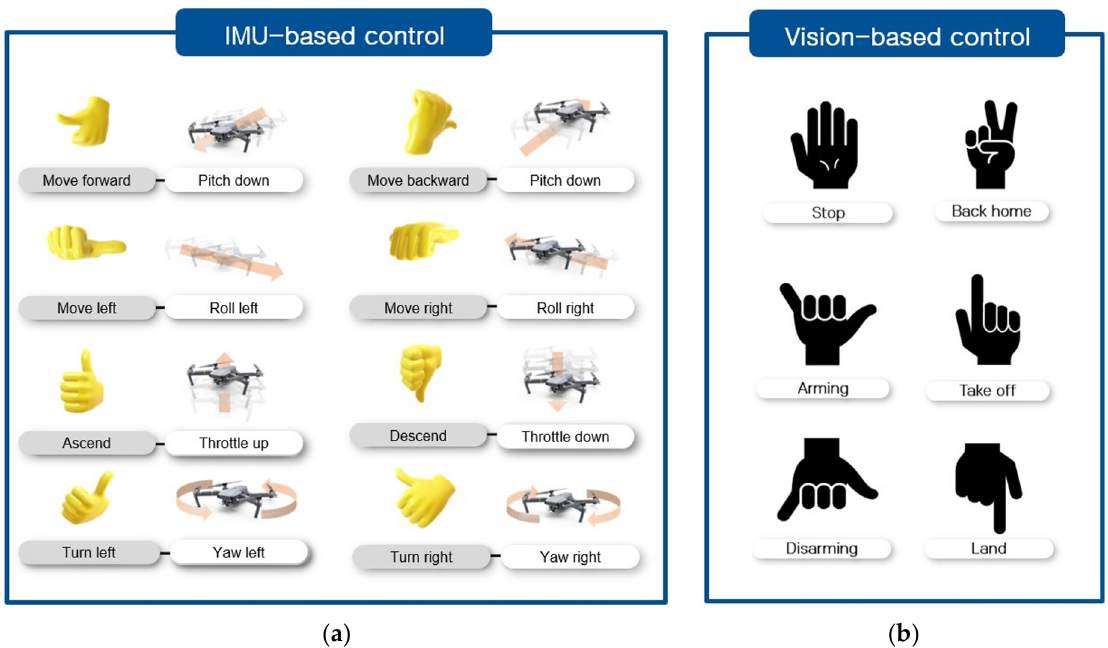
Figure 4. ( a ) Dynamic gestures for IMU-based gesture recognition.; ( b ) Static gestures for vision-based gesture recognition.